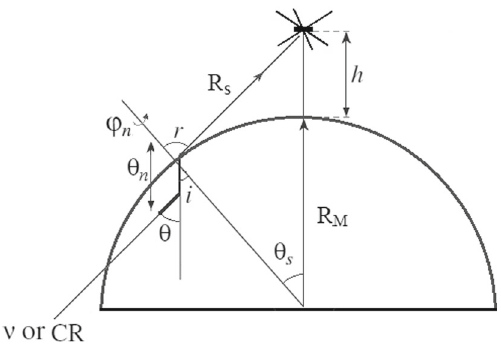
Fig. 1 Schematic view of lunar antenna detections of Askaryan radio emissions produced by the UHECR or UHEC ν in the lunar soil